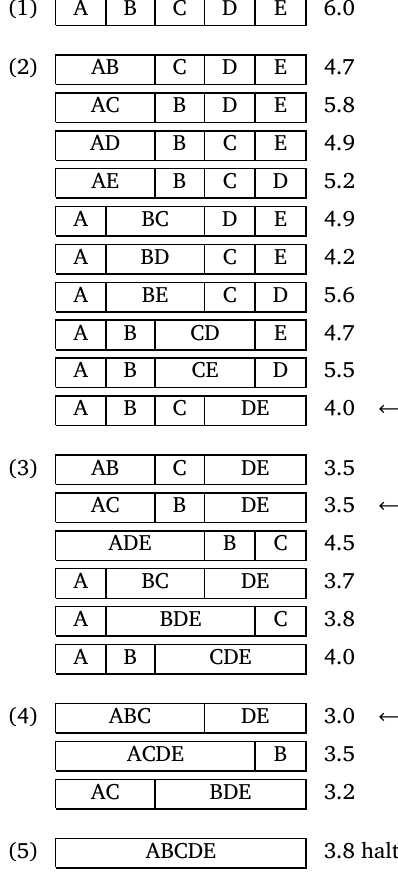
Example of a run of the search